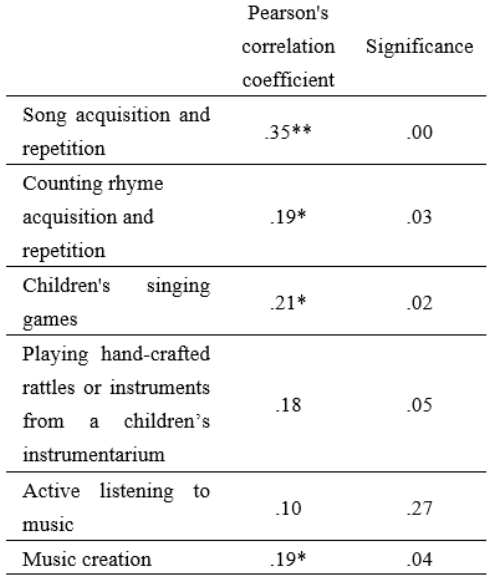
Table 6. Correlation of the respondents’